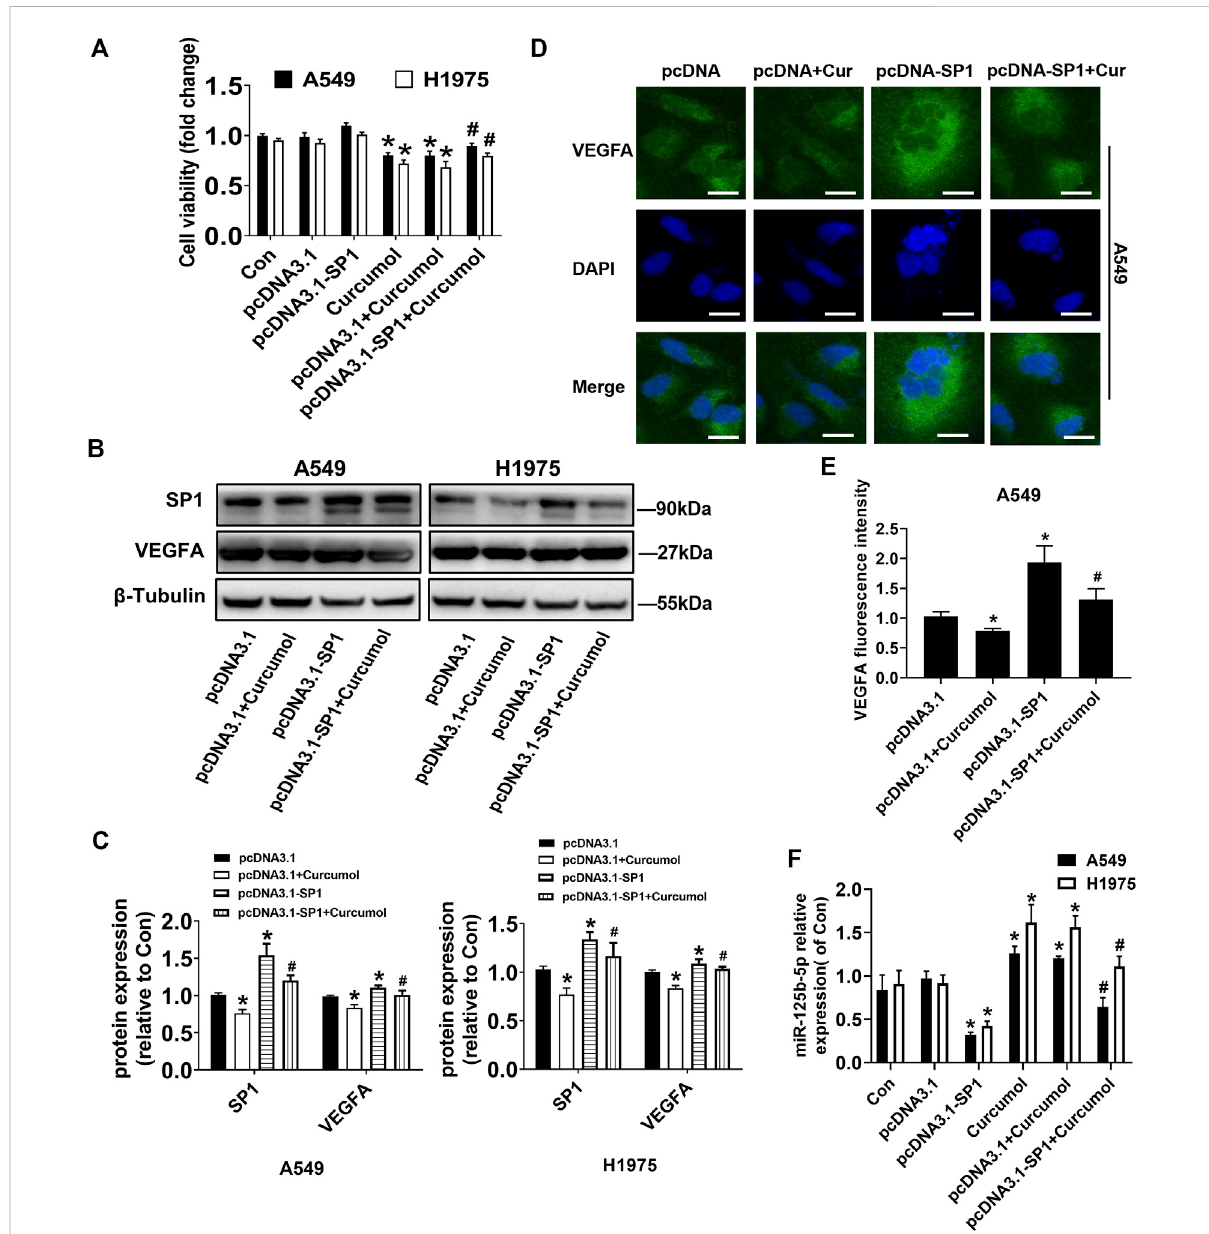
FIGURE 4 Overexpressed SP1 impacted Curcumol-mediated cell viability, VEGFA and miR-125b-5p. (A) A549 and H1975 were transfected with SP1 overexpression plasmid (pcDNA3.1-SP1 0.5 μ g/ml) or control plasmid (pcDNA3.1) for 24 h, followed by added with Curcumol for another 24 h. CellviabilitywascalculatedbyOD(opticaldensity)numberofeachwell. (B , C) Proteinexpressionlevel ofSP1,VEGFAweredetectedbyWesternblot, with β -Tubulin as internal control. (D , E) The expression of VEGFA protein in A549 cells was detected by cellular immuno fl uorescence, and the localization and semi quanti fi cation were performed. DAPI was used to display nuclei. Scale bar, 20 μ m. (F) NSCLC cells were transfected with vectors, followed by treating with Curcumol ( fi nal concentration 400 μ M) for 24 h. Expression of miR-125b-5p were detected by qTR-PCR, with U6 as internal reference. The data are presented from fi ve independent experiments (n = 5) run in triplicate. * p < 0.05, compared with control (Con). # p < 0.05, compared with pcDNA3.1 + Curcumol